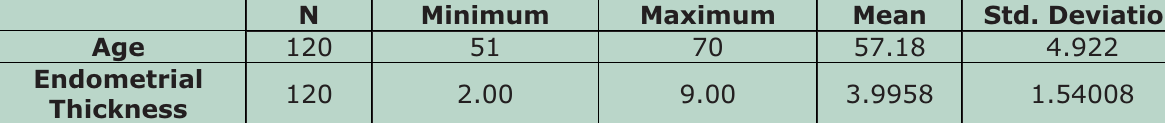
Table-II: Mean age & endometrial thickness.